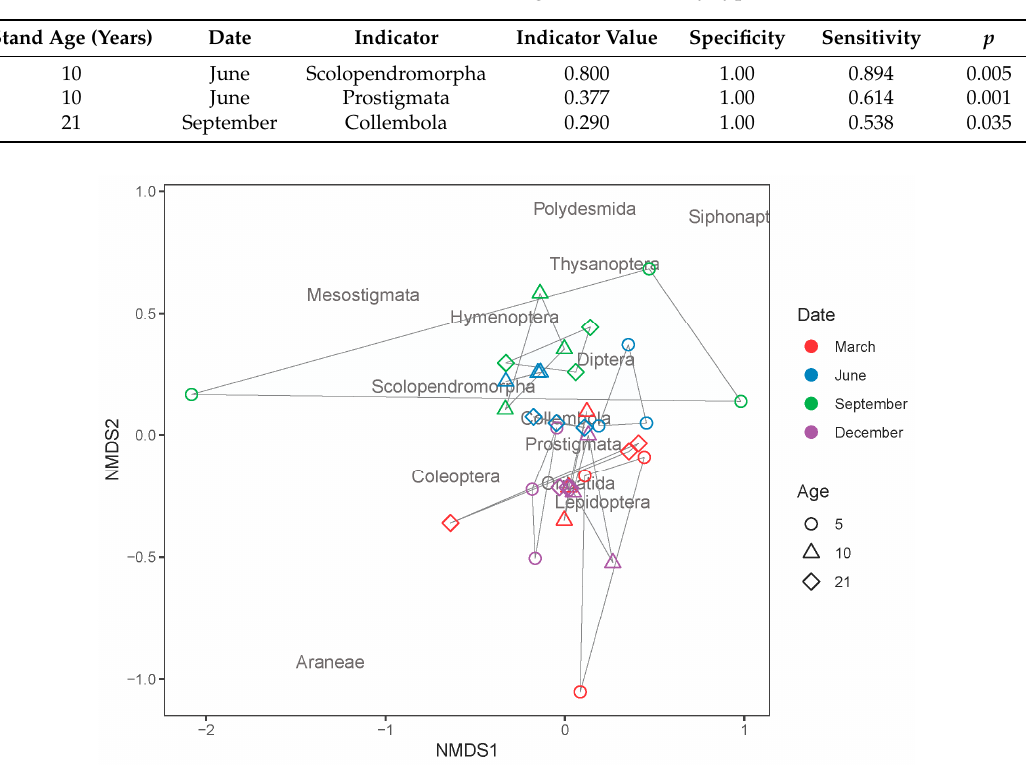
Table 4. Stand characteristics ( n = 3) along an age chronosequence of poplar plantations in a coastal region of Eastern China. Dimension